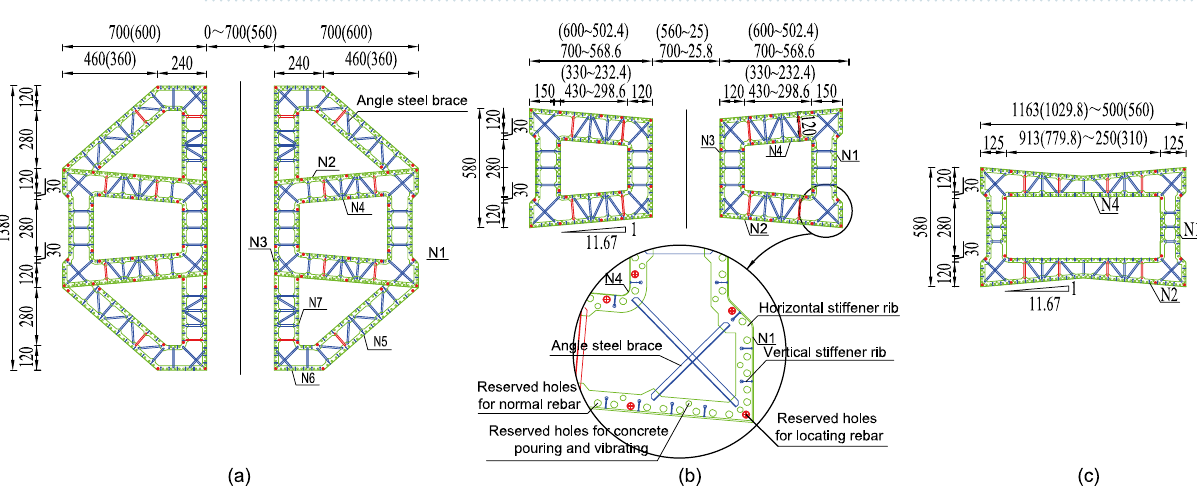
Figure 4. Steel shell structures of the pylon: ( a ) steel shell structure of lower part of the pylon; ( b ) steel shell structure of middle part of the pylon; ( c ) steel shell structure of upper part of the pylon.